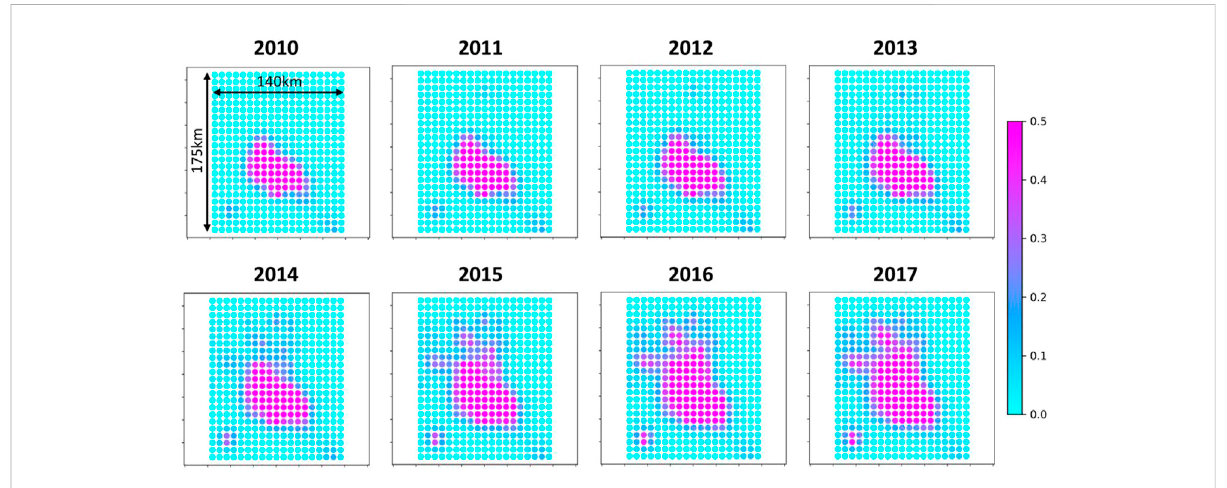
Changes in pore pressure (in MPa) at 4 km depth along the basement